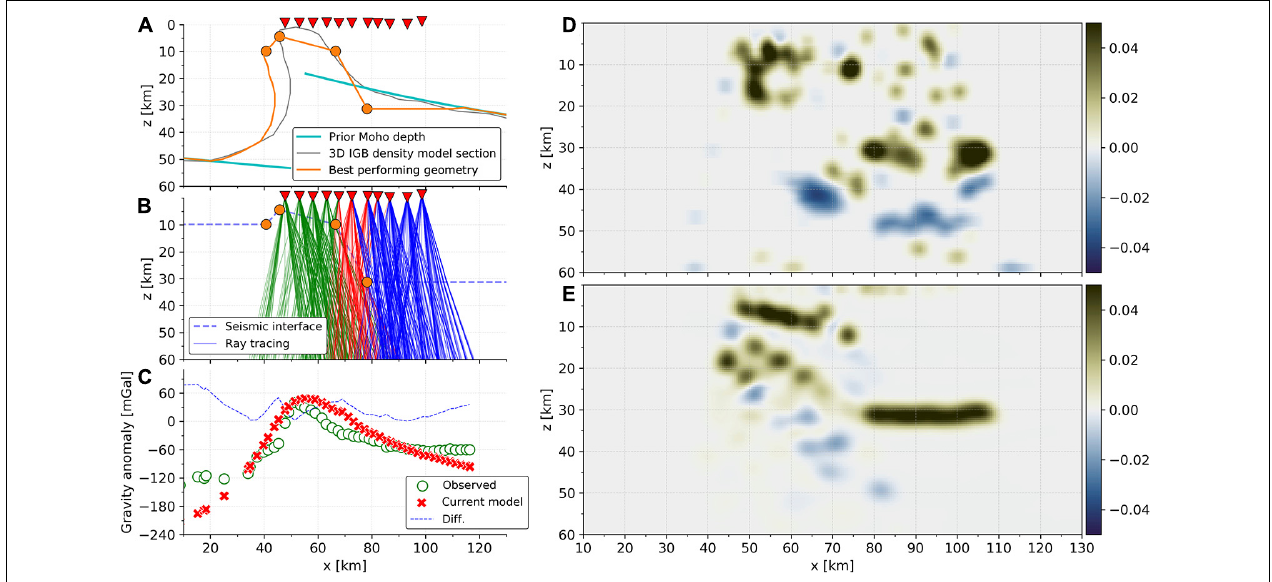
FIGURE 6 | Example of forward model calculation demonstrated on the best performing IGB model. (A) The current model geometry (orange line), defined by four nodes (orange circles) and assumptions as in Figure 5 . (B) Seismic ray-tracing across the model interface (blue dashed line segments) for the current velocity model. Seismic rays are colored according to the interface segment they cross along their path. The wave mode conversion respects Snell’s law considering the local interface dip. (C) Comparison between observed and synthetic gravity anomalies for the current model, and their misfit. (D) Observed-RFs migration, including ray-tracing and migration with the velocity structure of the current model. (E) Synthetic-RFs migration, using RFs generated by the current velocity structure, and then treated the same way as the observed RFs. The comparison between Observed-RFs and Synthetic-RFs migrations is obtained via image cross-correlation (further details in the